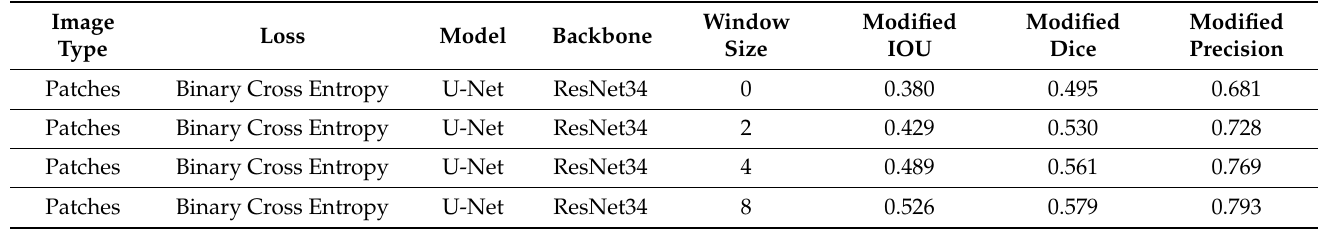
Table 4. Training and testing on B-Scans using (4) window sizes for patches using the Binary Cross Entropy loss function and U-Net-ResNet34